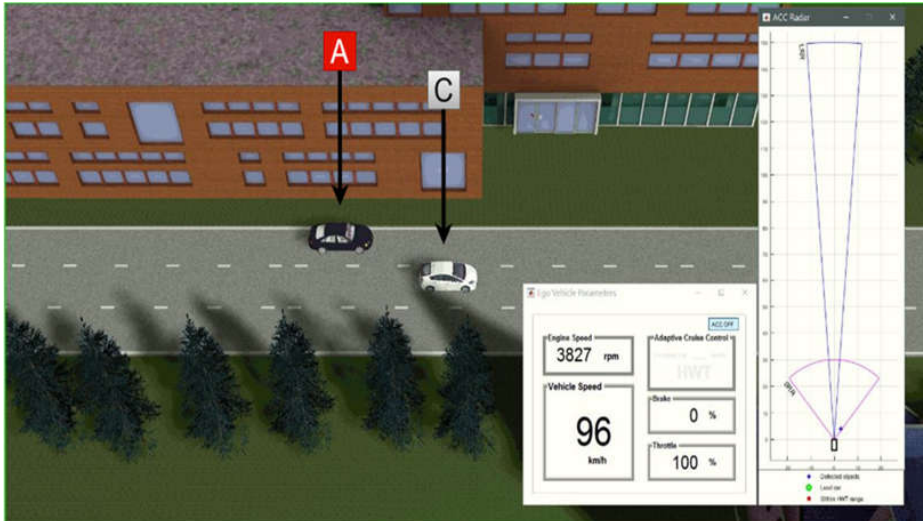
Figure 13. Second phase of the overtaking maneuver.